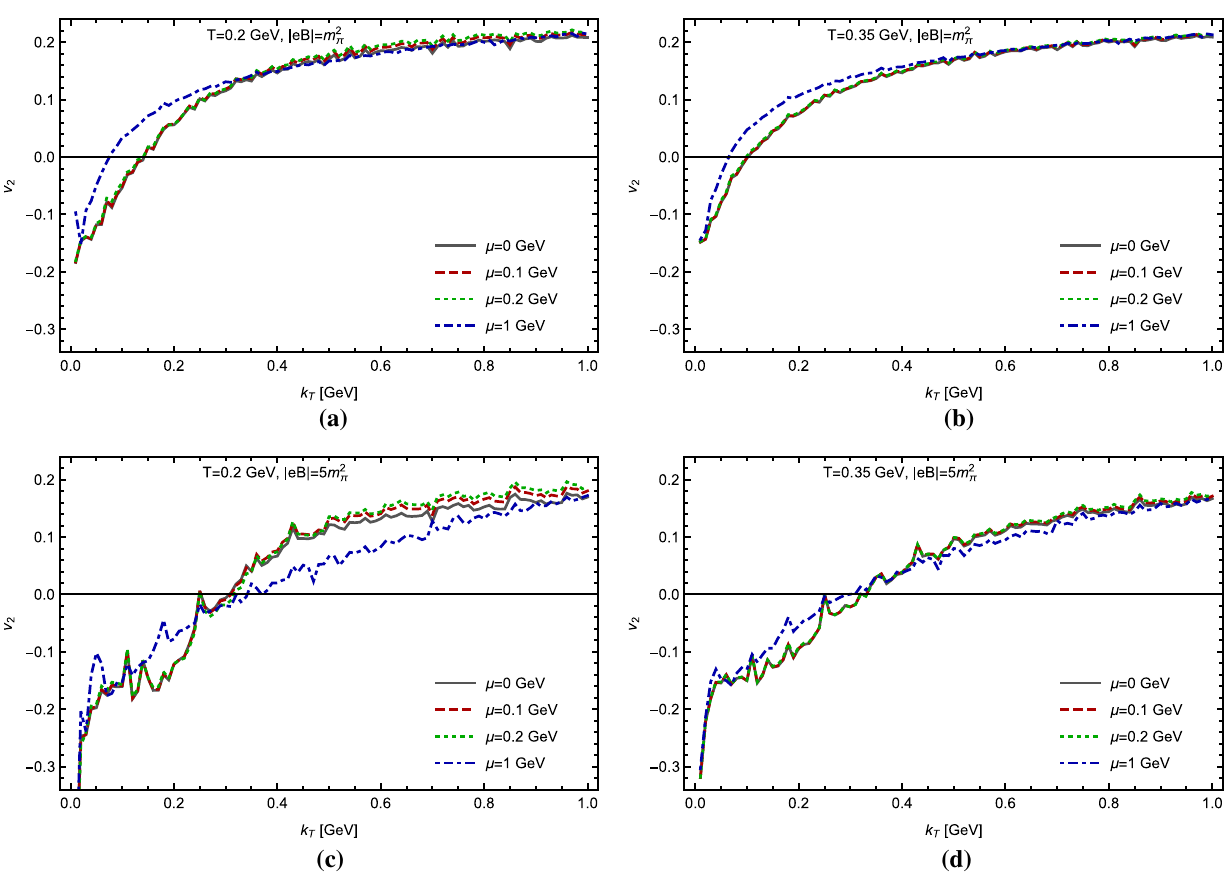
Fig. 6 Ellipticity of photon emission as a function of the transverse momentum k T forfourdifferentvaluesofthechemicalpotential: μ = 0 (gray lines), μ = 0 . 1 GeV (red dashed lines), μ = 0 . 2 GeV (green dot- ted lines), and μ = 1 GeV (blue dot-dashed lines). The left panels